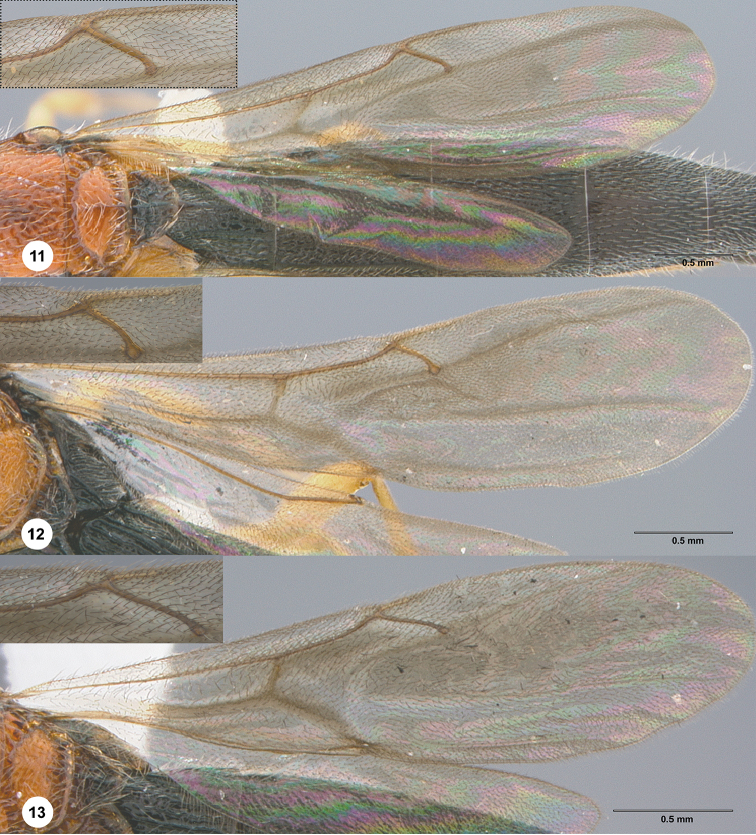
Wings 11Chromoteleialongitarsis Kieffer, female (OSUC584896). 12Chromoteleiarobusta sp. n., female, paratype (OSUC577466) 13Chromoteleiacuneus sp. n., female, holotype (OSUC585001).